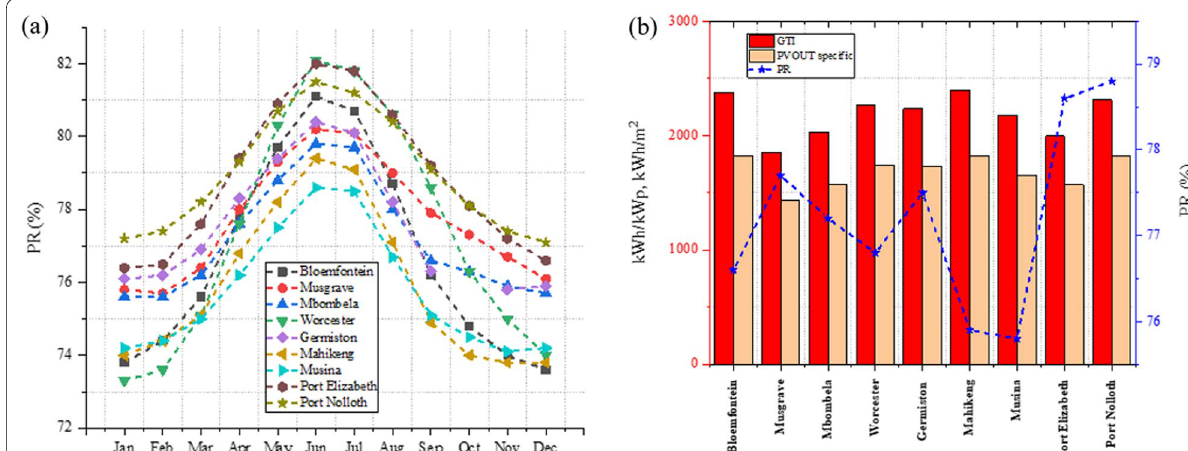
Fig. 8 PV system sites’ a solar PV PR profiles; b the PR, GTI, and the specific PV power output